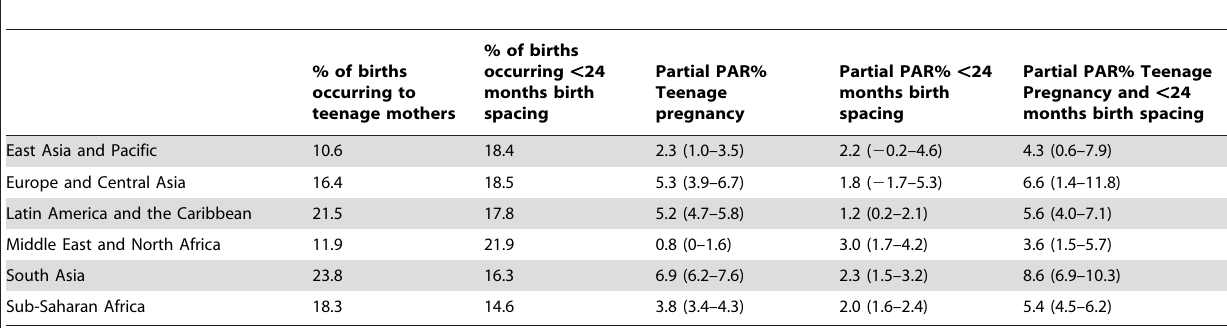
Table 3. Estimated percent reduction in stunted children by eliminating teenage pregnancy and birth intervals , 24 months* by World Bank region within DHS